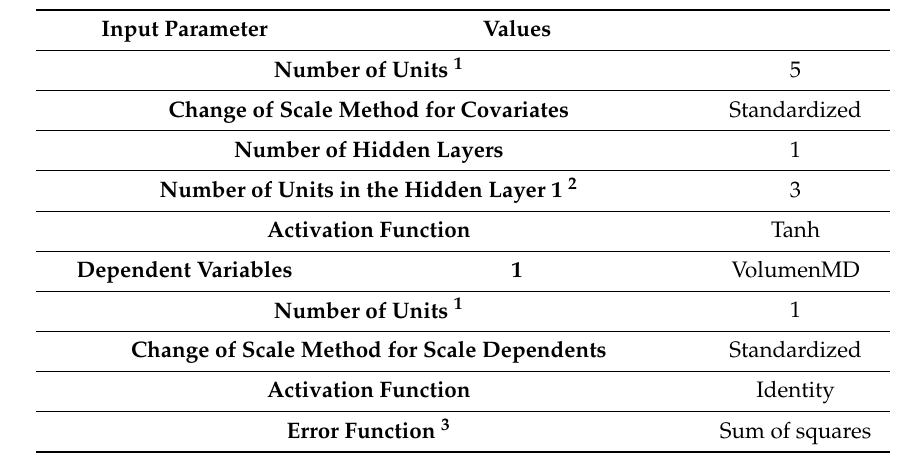
Table 2. Description of the network Volume. CPI: Consumer Price Index.